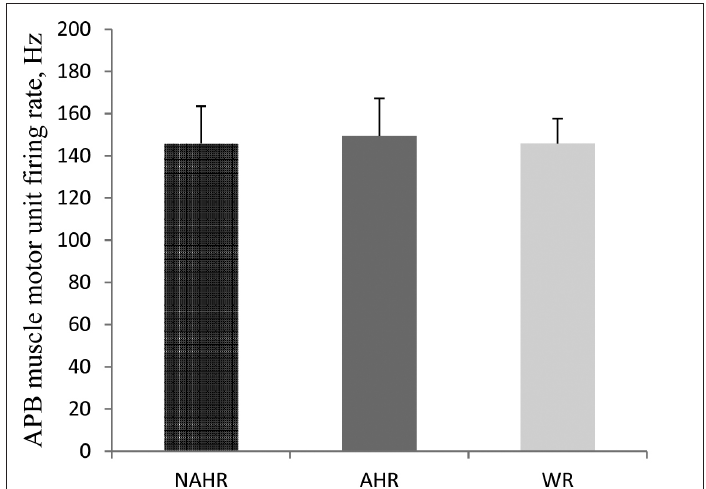
Figure 3. Stroke affected hand abductor pollicis brevis (APB) muscle motor unit firing rate during observation of thumb opposition of the non-affected hand reflection (NHR), affected hand reflection (NHR) and performing thumb opposition without reflection (WR) in the